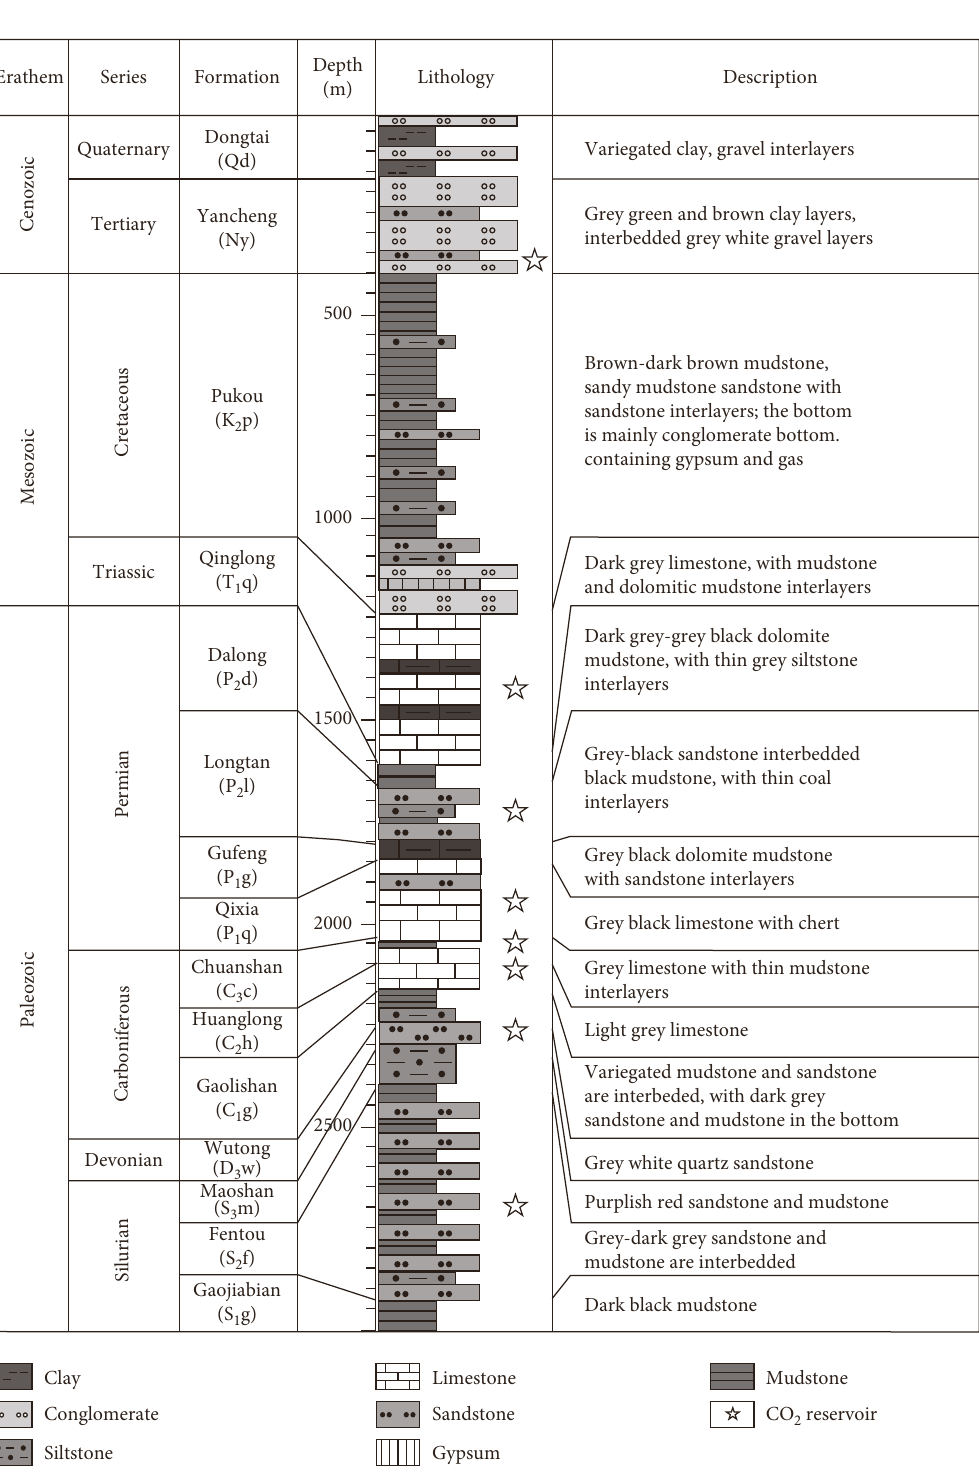
Figure 2: Stratigraphic column of the Huangqiao area (from Liu et al.